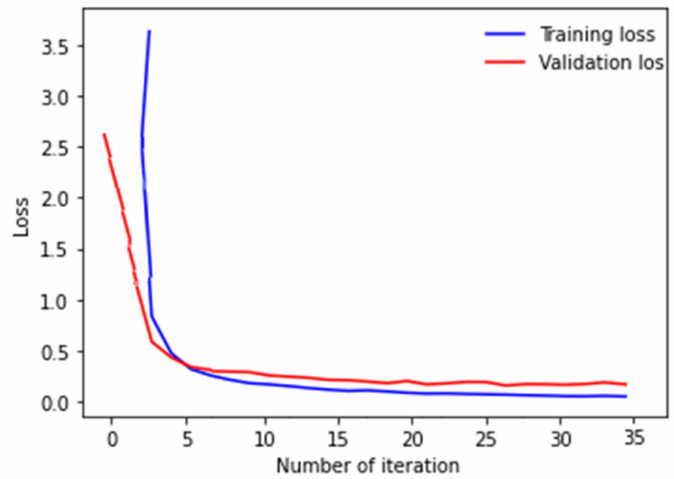
Figure 14. Training and validation learning curves on